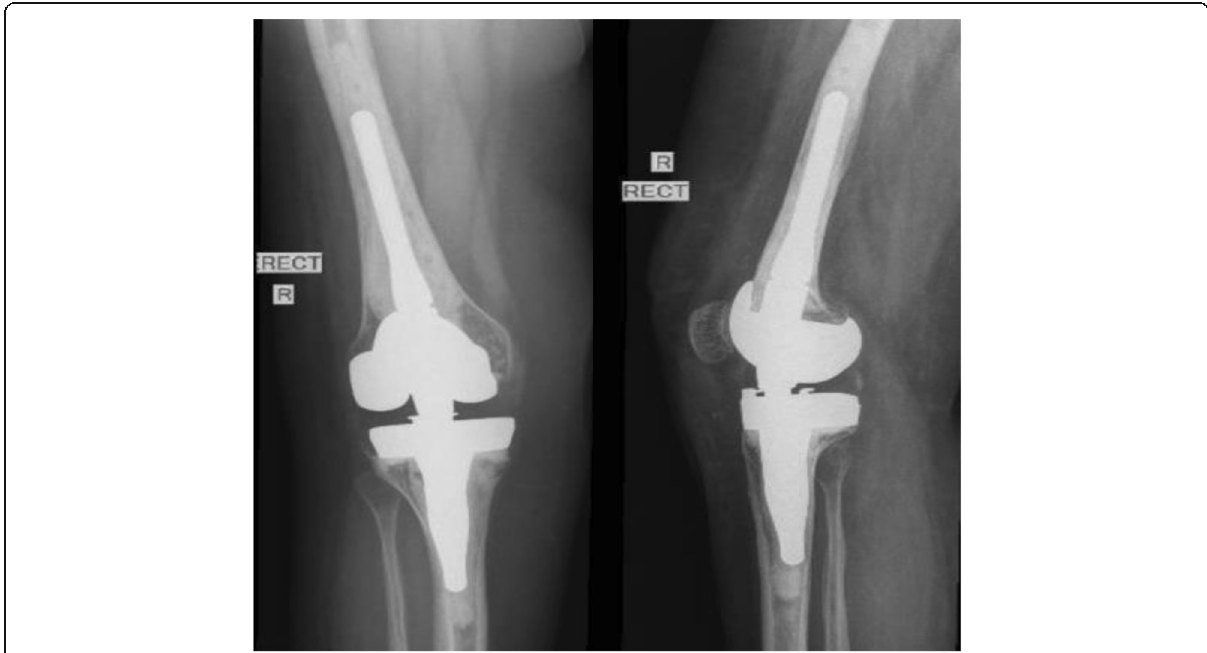
Fig. 3 A postoperative AP and lateral radiograph of the knee demonstrating the cemented hinged prosthesis